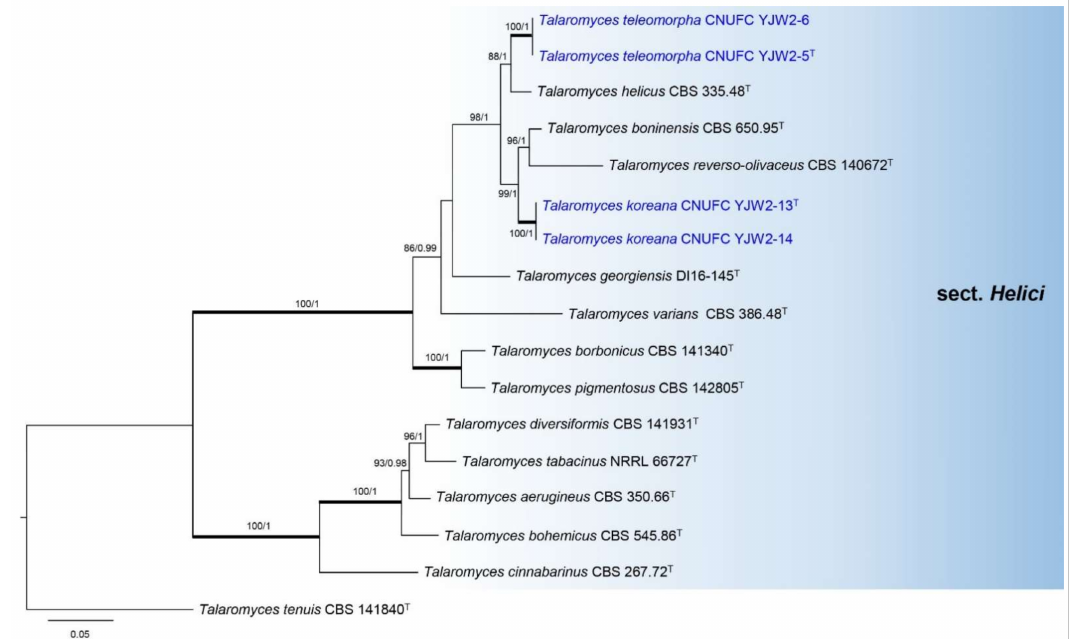
Figure 3. Phylogram generated from the Maximum Likelihood (RAxML) analysis based on combined the ITS, BenA , CaM , and RPB2 sequence data for the species classified in Talaromyces section Helici . The branches with values = 100% ML BS and 1 PP are highlighted by thickened branches. The branches with values ≥ 70% ML BS and ≥ 0.95 PP indicated above or below branches. Talaromyces tenuis CBS 141840 was used as the outgroup. The newly generated sequences are indicated in blue. T =